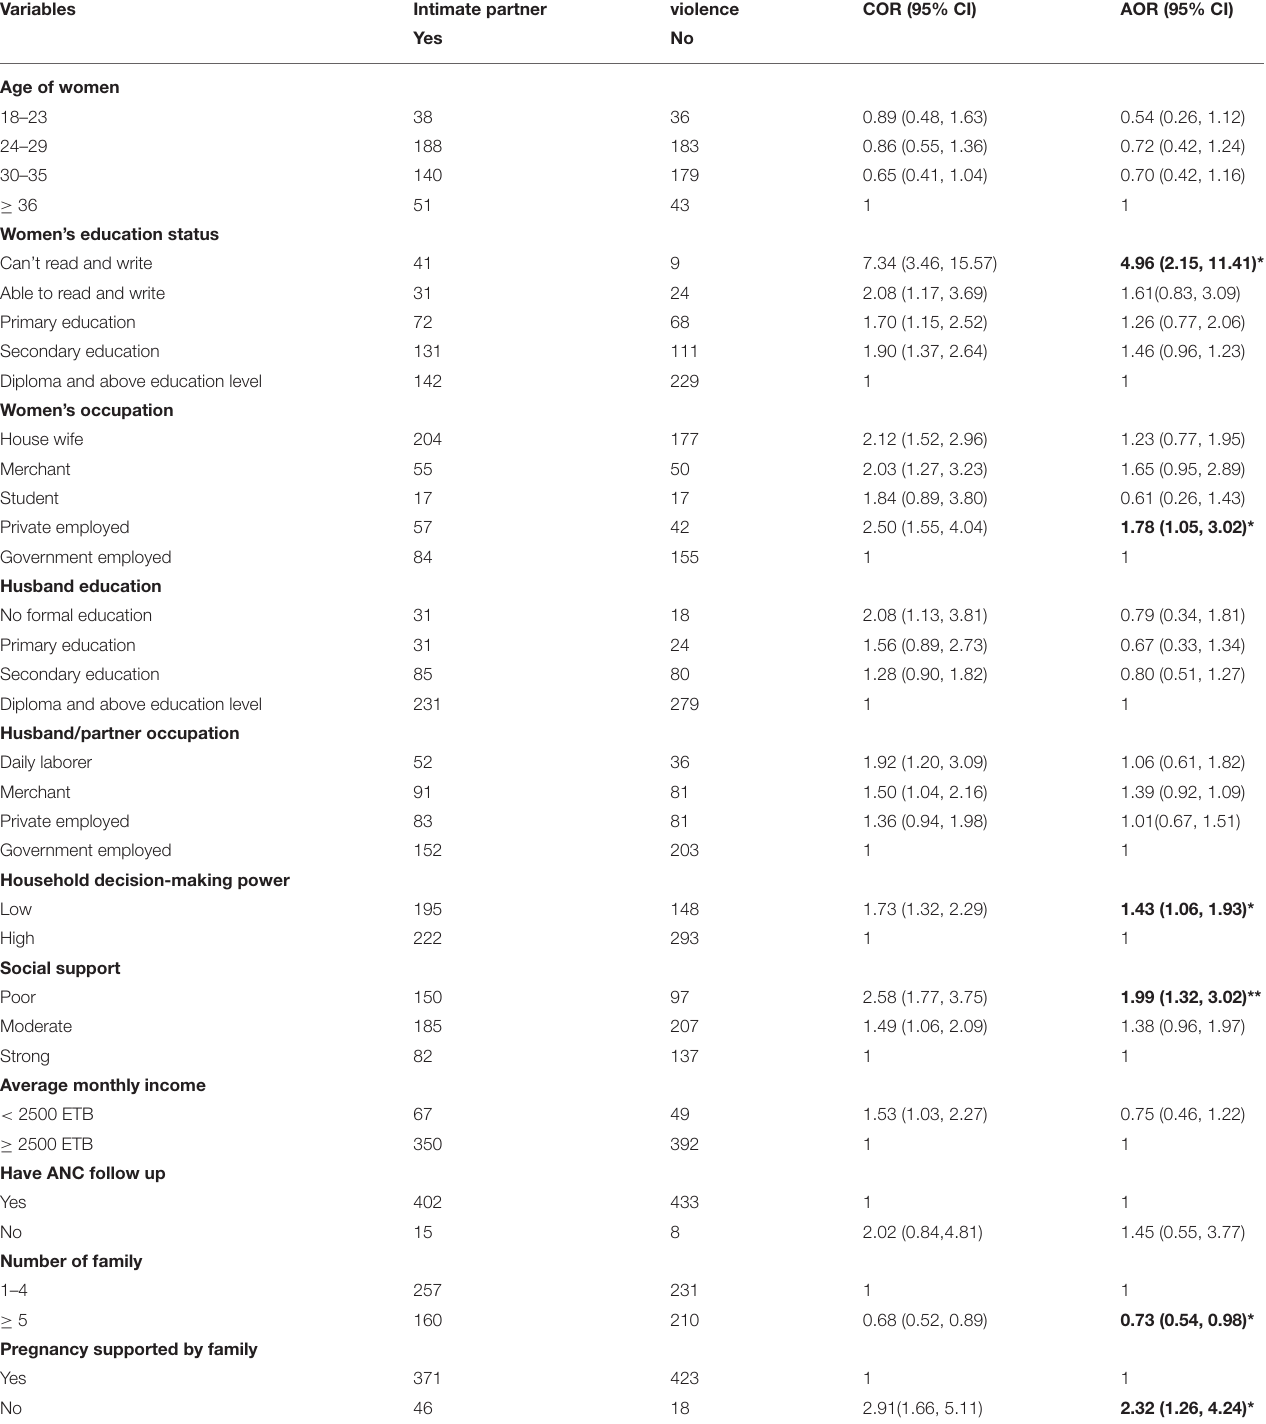
TABLE 3 | Bivariable and multivariable logistic regression analysis of factors associated with intimate partner violence among pregnant women in Gondar city, northwest Ethiopia, 2021.